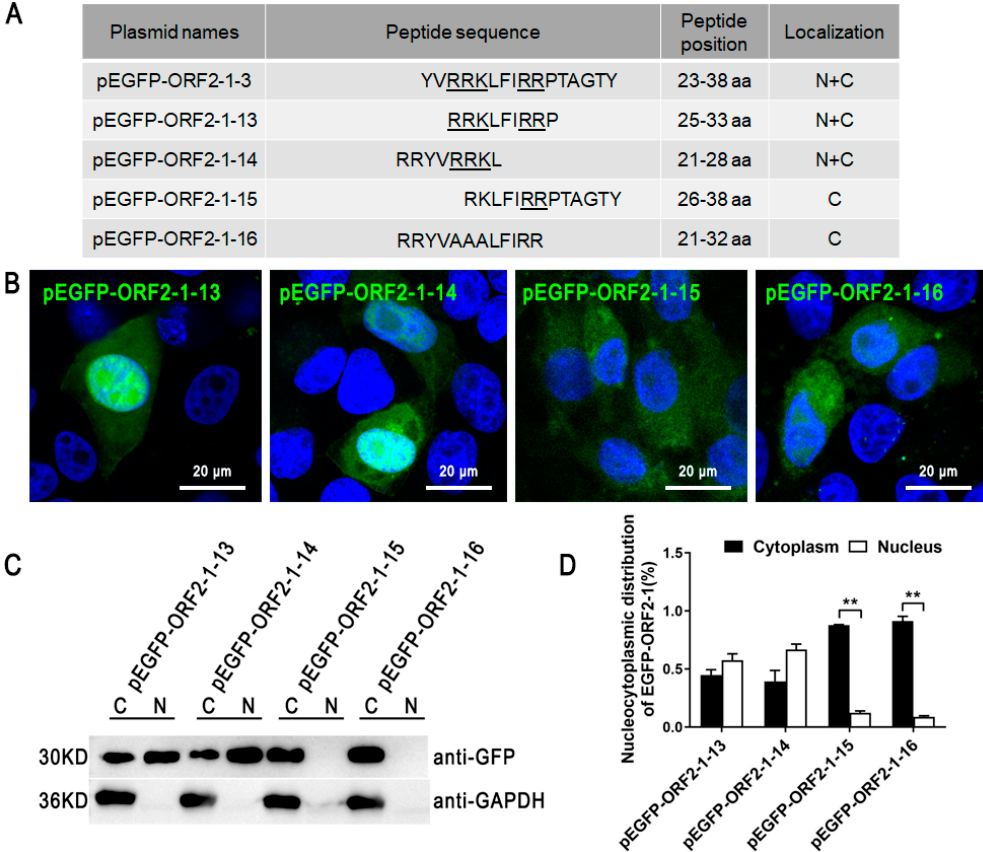
Figure 4. The key amino acids of NLS in ORF2-1-3. ( A ) Mutants of ORF2-1-3 gene were inserted into pEGFP-C3, and the key amino acids predicted in ORF2-1-3 are listed by underline. ( B ) PK-15 cells were transfected with mutant plasmids, and the localization of fusion proteins was observed by confocal microscopy. Scale bars = 20 μ m. ( C ) and ( D ) After 24 h, the nucleus and cytoplasm in transfected cells were extracted and the expressed proteins were determined by western blot. Nuclear / cytoplasmic distribution of the expressed proteins was further analyzed through densitometric quantification using Image-Pro software, data from three independent experiments are shown on the graph as the average ± standard error. One-way ANOVA; ** p < 0.01.